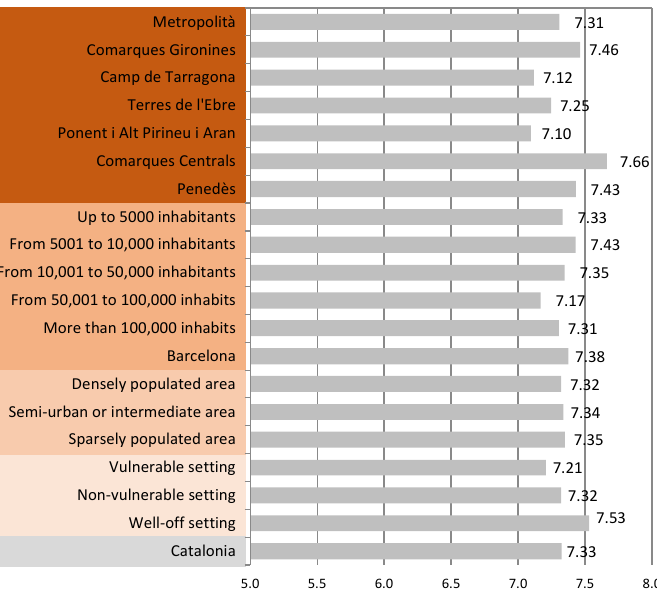
Figure 6. Life satisfaction. Population aged 16 and over. Catalonia. Source: In-house construction based on the ECVHP, 2011.